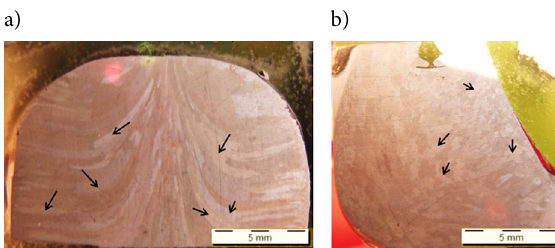
Fig. 2. Cross-cut of connecting rod, black arrows show coarse crystallized grains (light areas) at: a – longitudinal direction; b – transverse